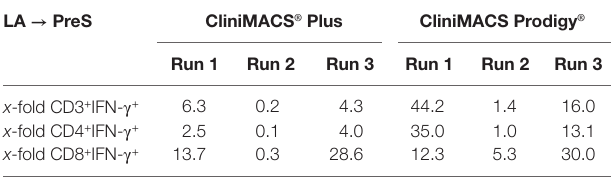
tABLe 2 | Results of antigenic restimulation ex vivo of CMV-specific t-cells by Plus and Prodigy procedure. LA → Pres